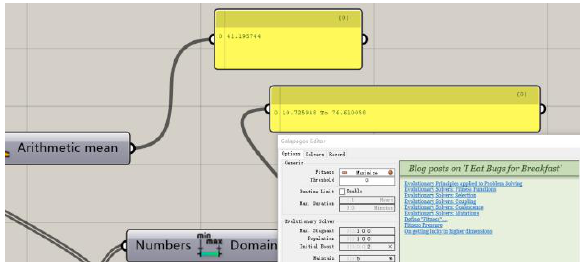
Figure 3. Genetic algorithm for optimal solution After a few minutes, the average deviation of the center of the current and rebuilt column base is 41mm, which is distributed in the range of 10mm ~ 76mm. The direction of the green arrow is, the center of the current column base points to the center of the rebuilt column base, and the number is the deviation value, e.g.